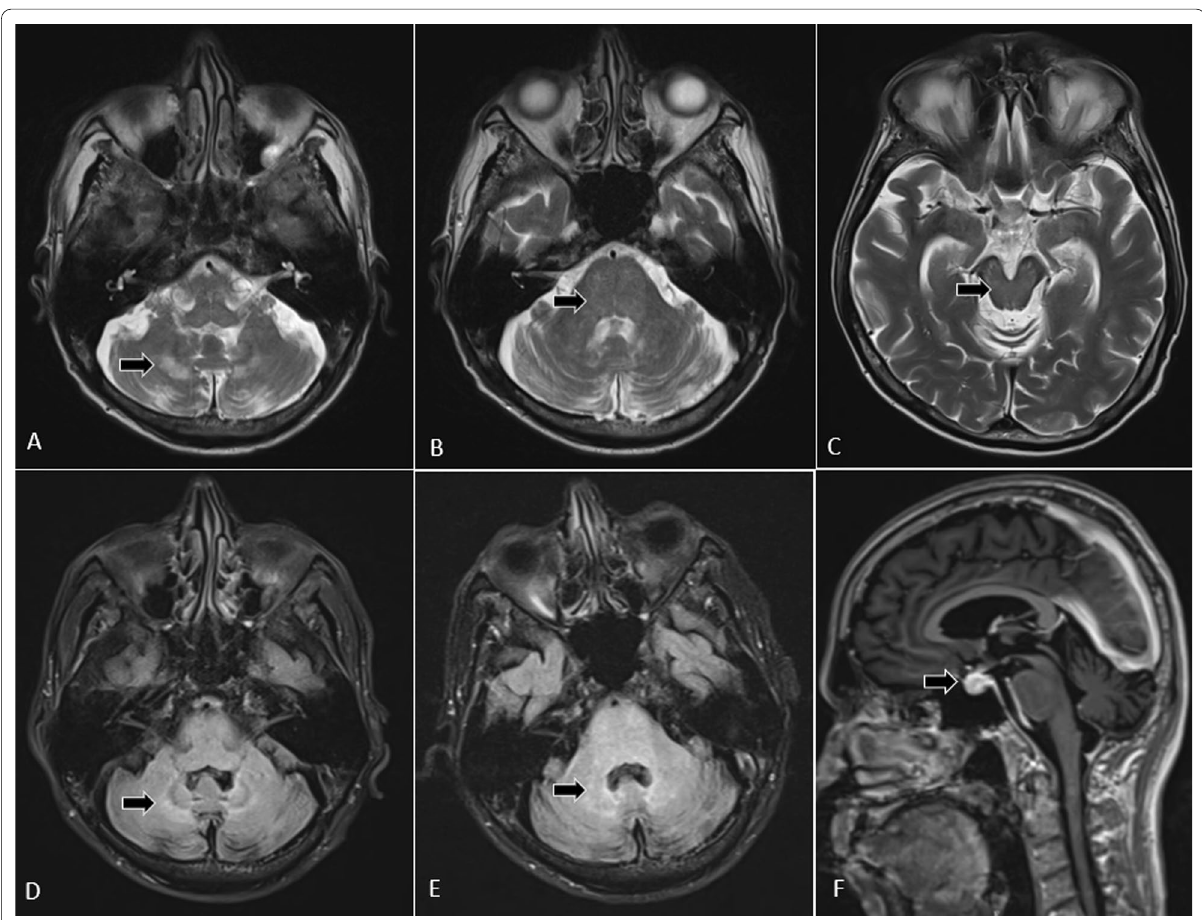
Fig. 1 Magnetic resonance imaging of brain in a 60-year-old male patient diagnosed with Erdheim–Chester disease reveals hyperintense signal in pons, midbrain, cerebellum and bilateral middle cerebellar peduncles on T2W axial images ( A – C ) and FLAIR images ( D , E ). The post-contrast T1 sagittal image ( F ) shows enlarged homogeneously enhancing pituitary